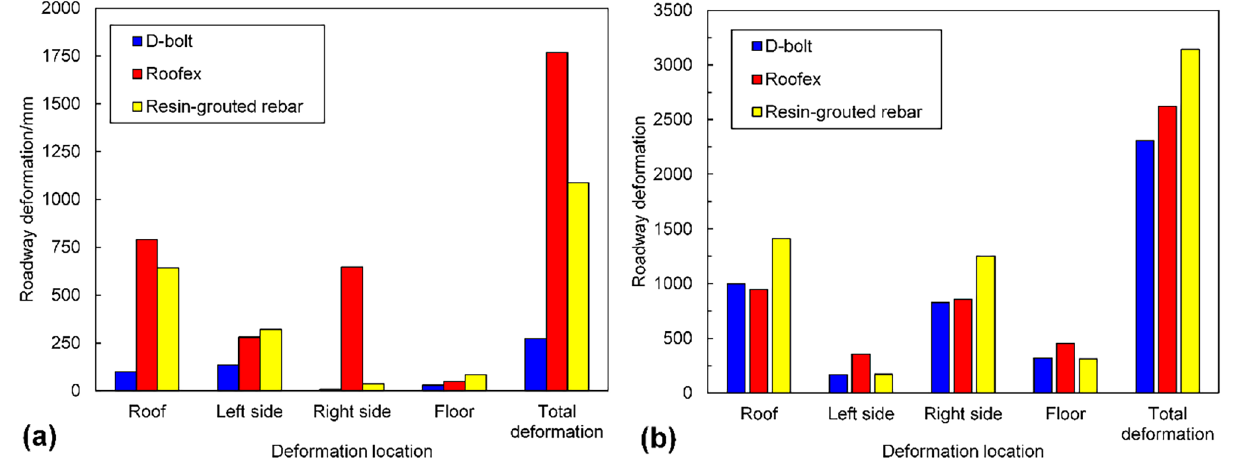
Fig. 13 Comparison of the deformation of the tunnel supported by different types of rockbolts. a PPV = 0.2 m/s; b PPV = 0.8 m/s